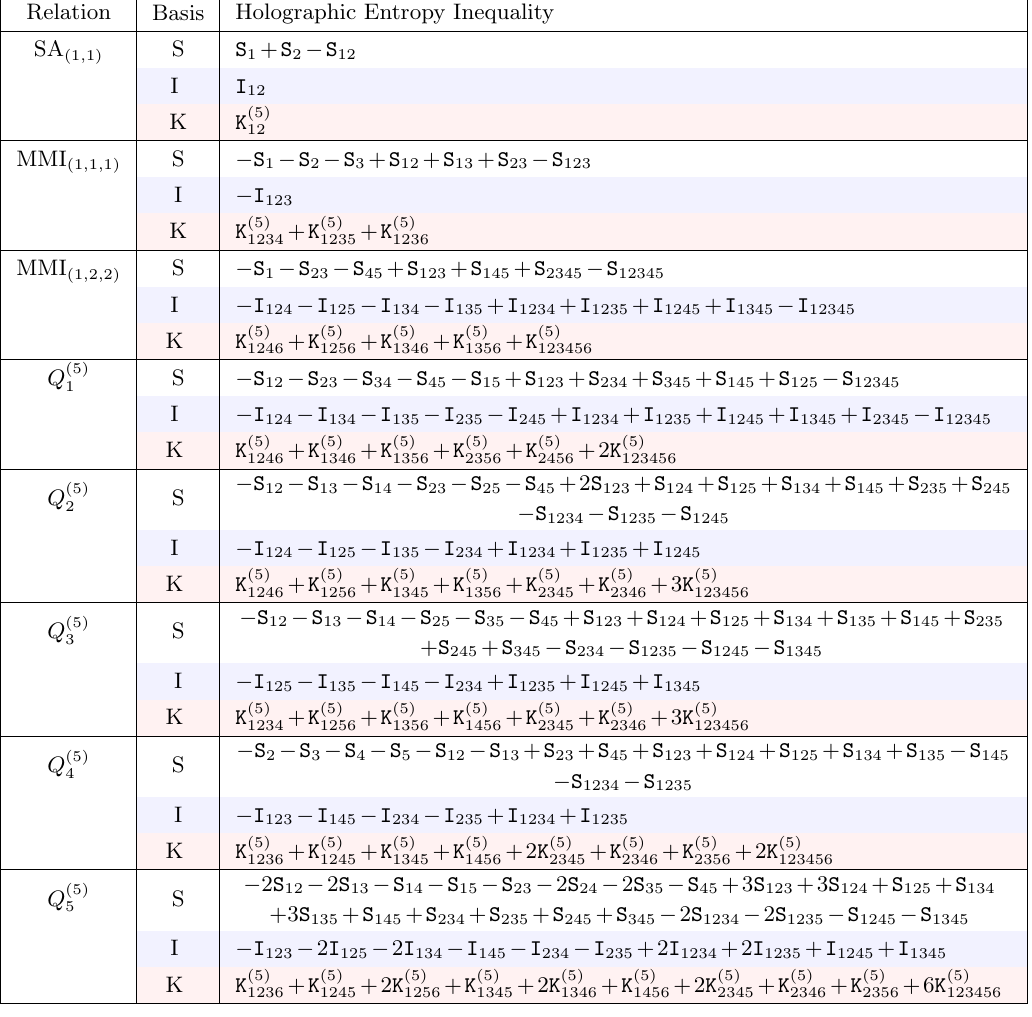
i in all the HEIs are (cid:0)